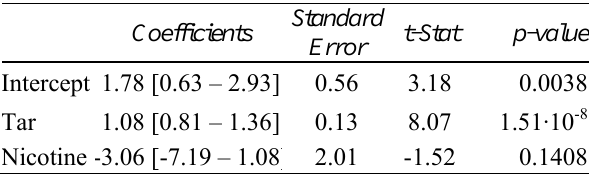
Table 3: Statistical characteristic of the regression model (Eq. 1)